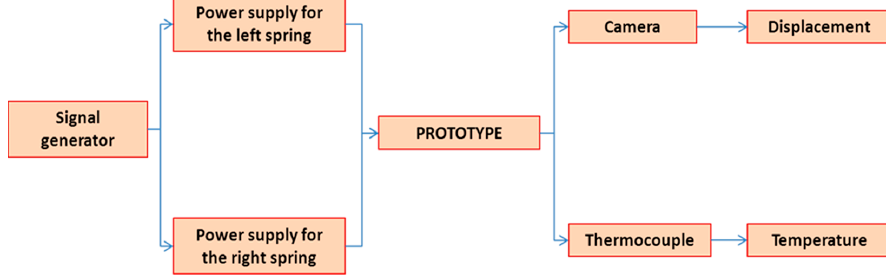
Figure 12. Setup block diagram.